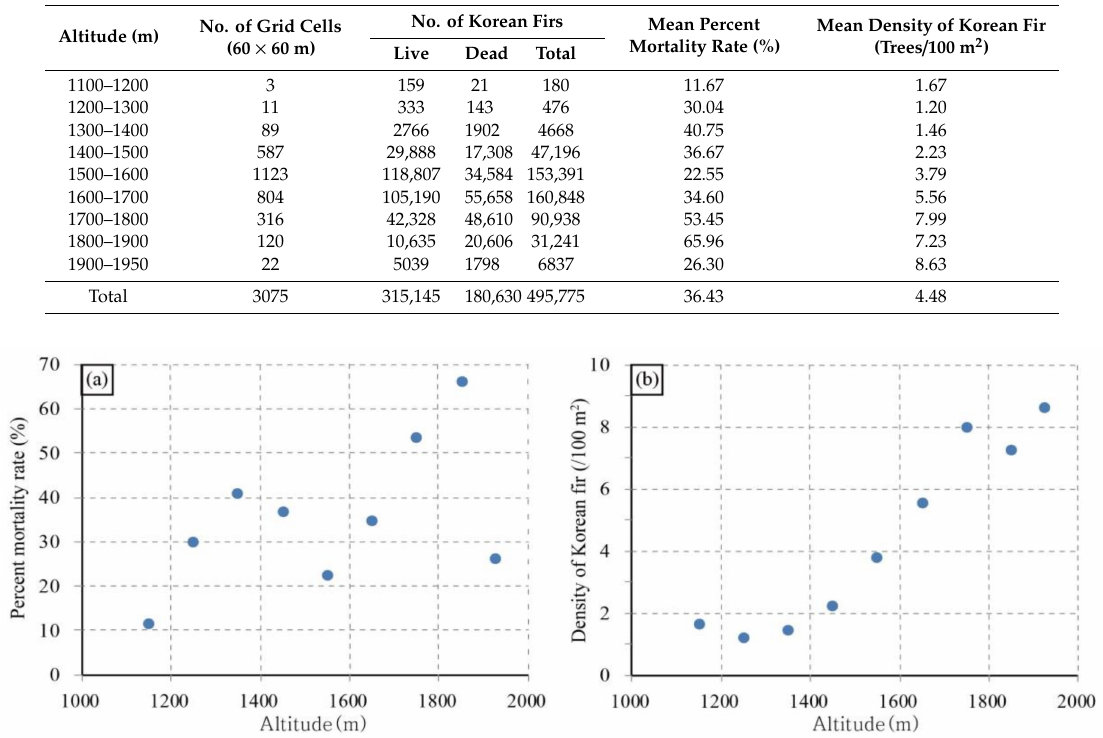
Table 5. APMR and density of the Korean fir within each 100 m altitude interval.